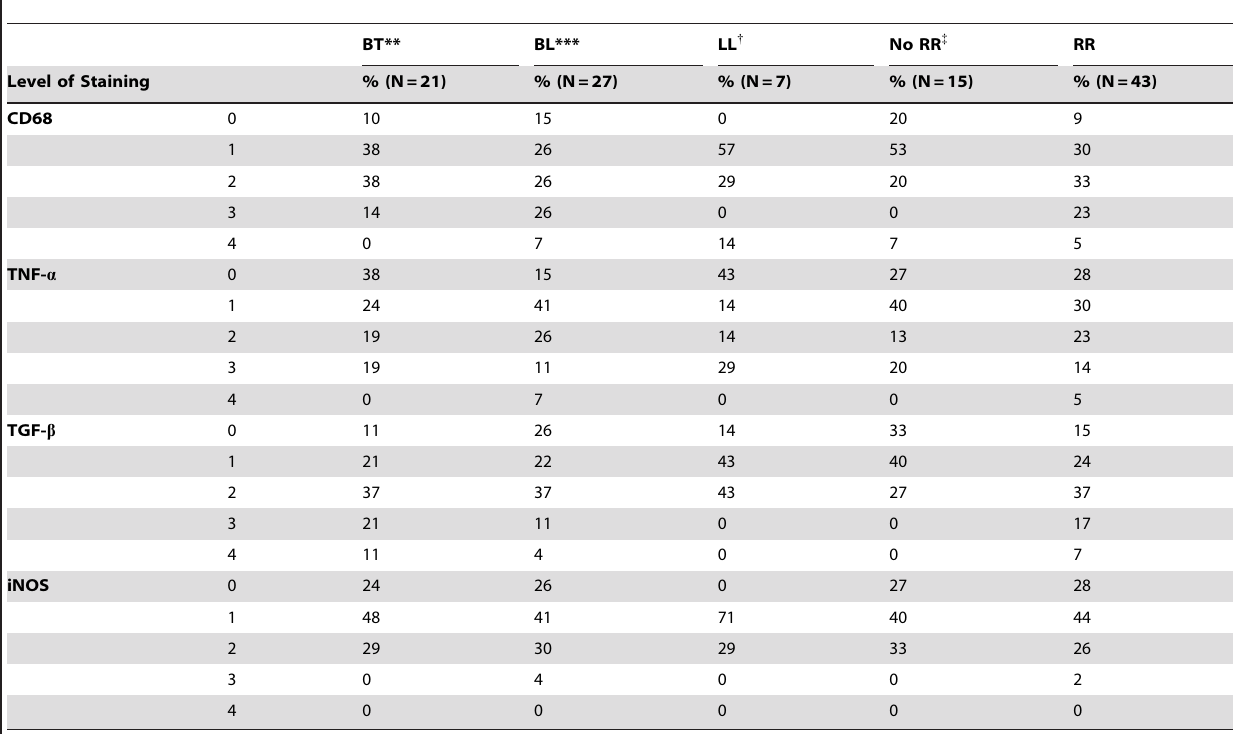
Table 6. Immuno-staining in nerve biopsies for CD68, TNF- a , TGF- b and